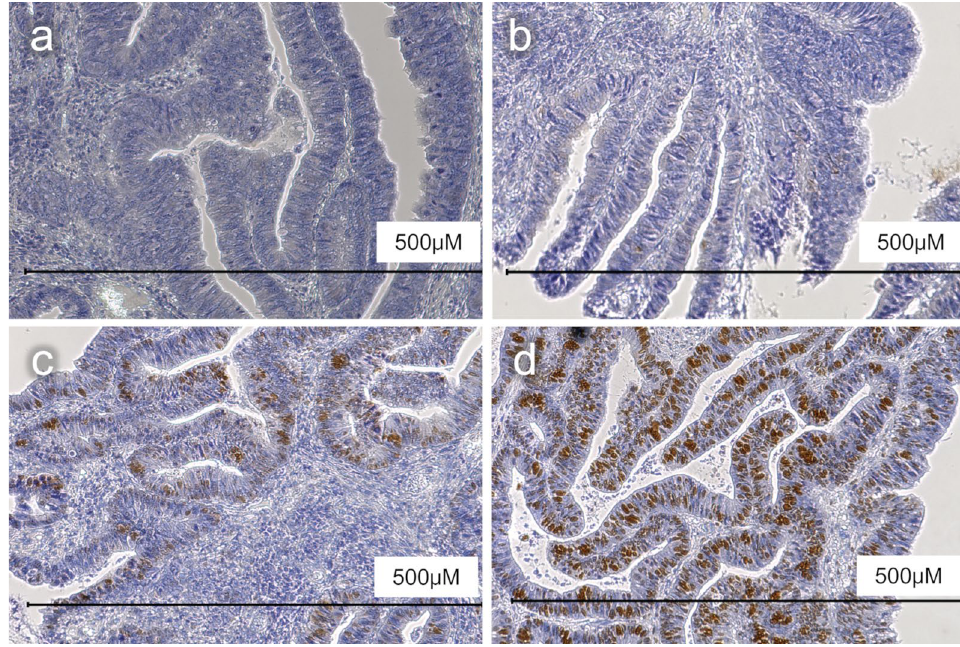
Fig. 5 Immunohistochemical analysis of MMRs. PMS2 ( a ), MLH1 ( b ), MSH2 ( c ), and MSH6 ( d